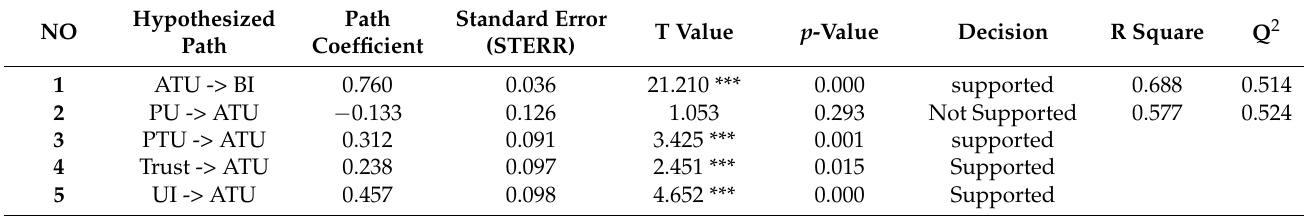
Table 4. Hypothesis testing